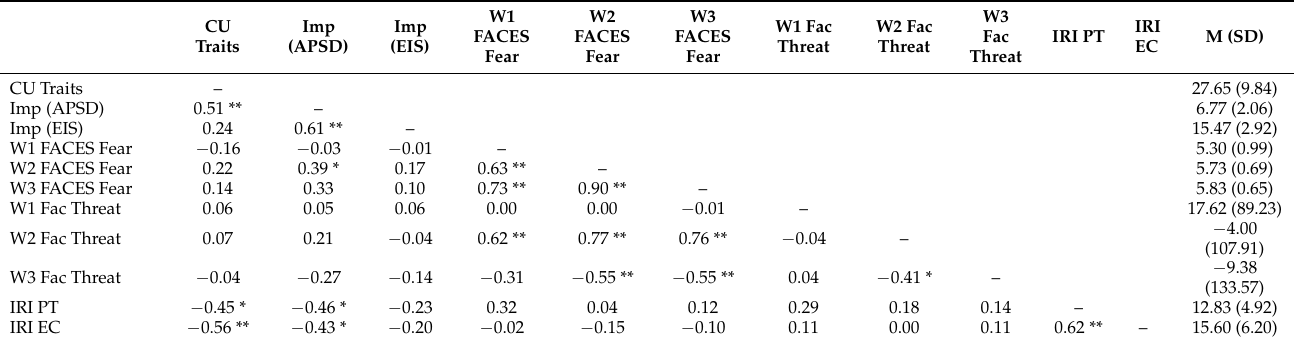
Table 3. Means, Standard Deviations, and Correlations among Primary Study